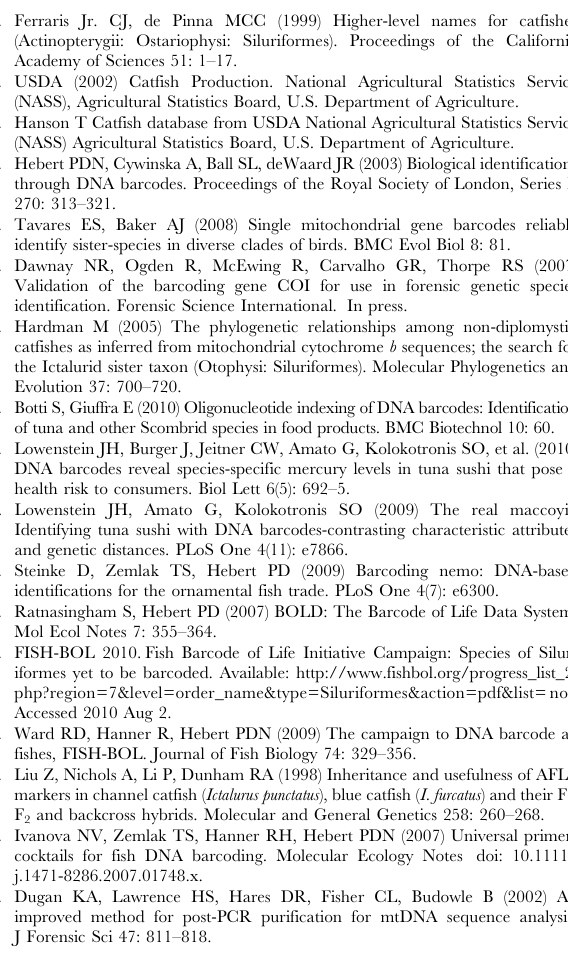
Table S2 Reference sequence numbers (BOLD) and accession numbers (GenBank) of voucher species used to build multiple sequence alignment of Ictalurus punctatus using CLUSTALW program in Figure